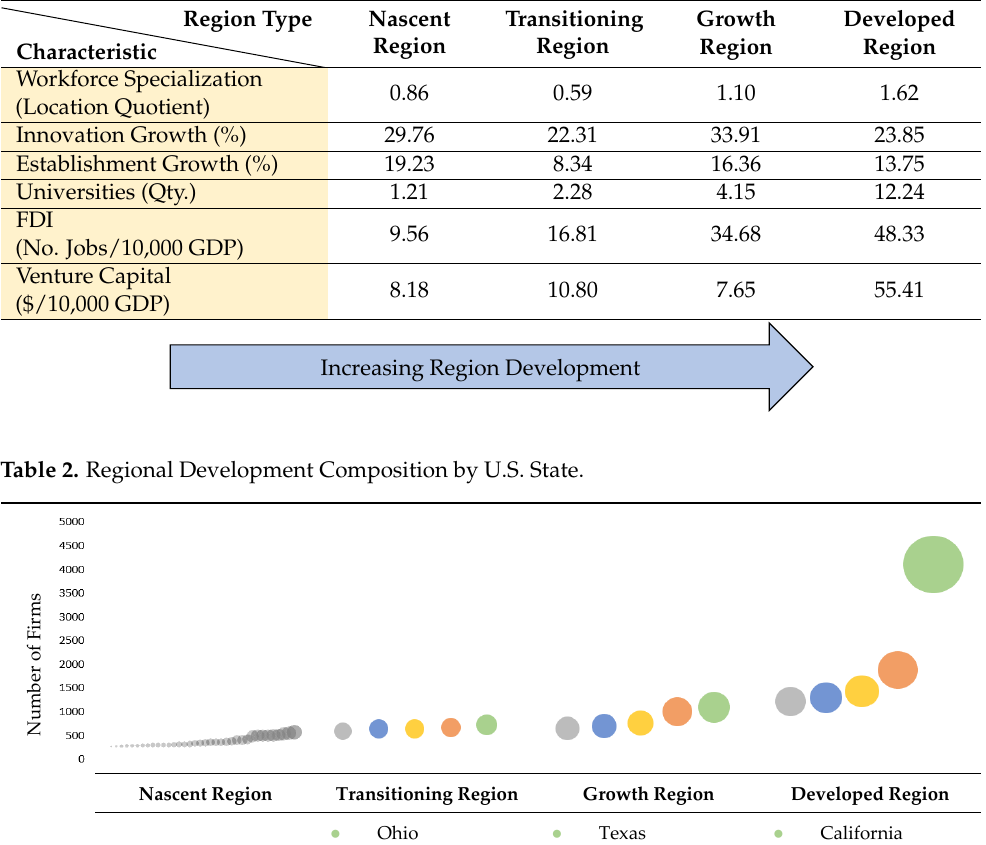
Table 1. Regional development typology and resource characteristics 1 .